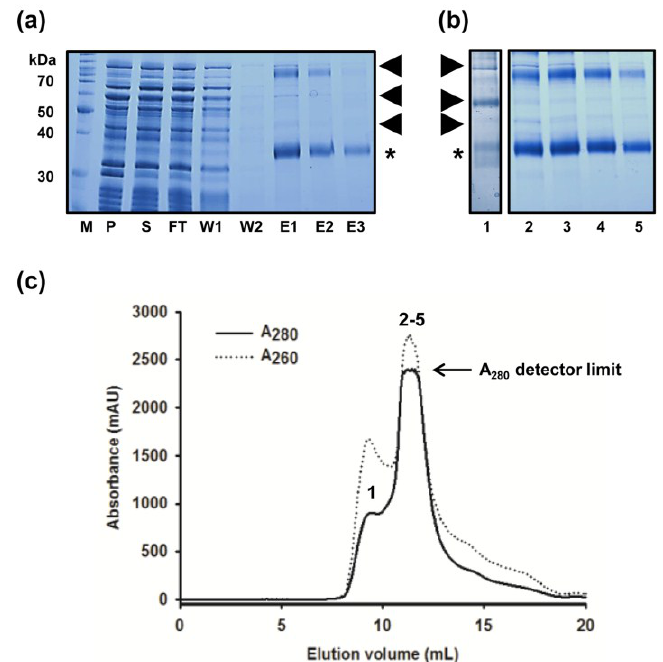
Figure 1. Purification of MdtM using the unmodified protocol. ( a ) Coomassie stained SDS-PAGE of protein fractions from Ni-NTA chromatography. Gel lanes were loaded with molecular weight marker (M), membrane pellet fraction (P), DDM-soluble fraction (S), column flow through (FT), wash one (W1), wash two (W2) and fractions eluted with 150 mM, 300 mM and 500 mM imidazole (E1, E2 and E3, respectively). Samples were incubated in SDS-PAGE sample loading buffer for 10 min at room temperature prior to loading onto the gel. A total of 8.4, 7.7 and 1.2 µg of protein were loaded from fractions E1, E2 and E3 respectively; ( b ) Coomassie stained SDS-PAGE of fractions from MdtM purification using FPLC size exclusion chromatography in 0.25 mM DDM. Lane 1, sample from the ~9.5 mL elution peak; lanes 2–5, samples from across the ~11.5 mL major elution peak. In both ( a ) and ( b ) MdtM is denoted with (*) and major contaminating proteins are labelled with arrows; ( c ) SEC chromatogram of MdtM. Protein absorbance at 280 nm and 260 nm is represented by the solid and dashed lines, respectively. Numerals above the absorbance peaks correspond to the gel lanes in panel ( b